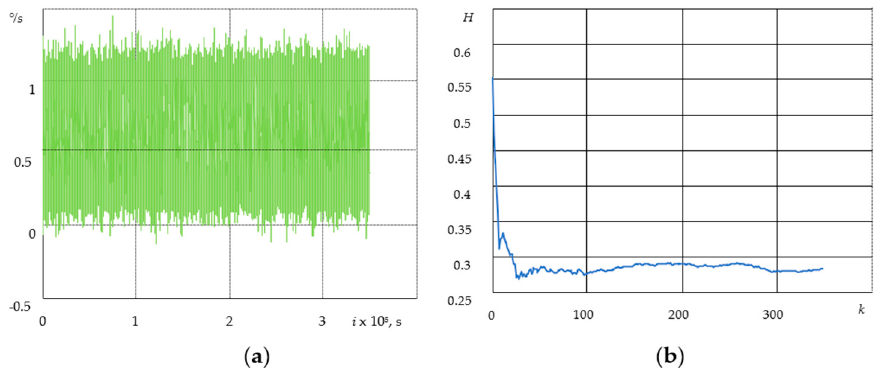
Figure 2. Gyroscope drift according to X coordinate ( a ) and the Hurst parameter with the gyroscope drift for 1 h ( b ).